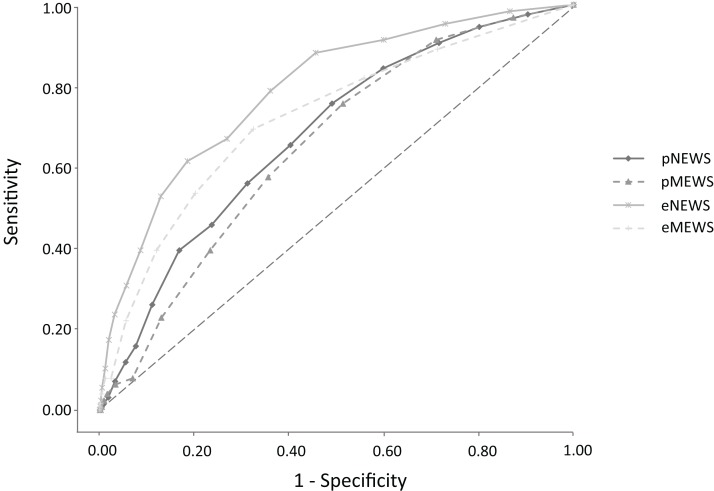
Receiver operator characteristic (ROC) curves for in-hospital mortality comparing the Early Warning Scores in the pre-hospital and in the emergency department.